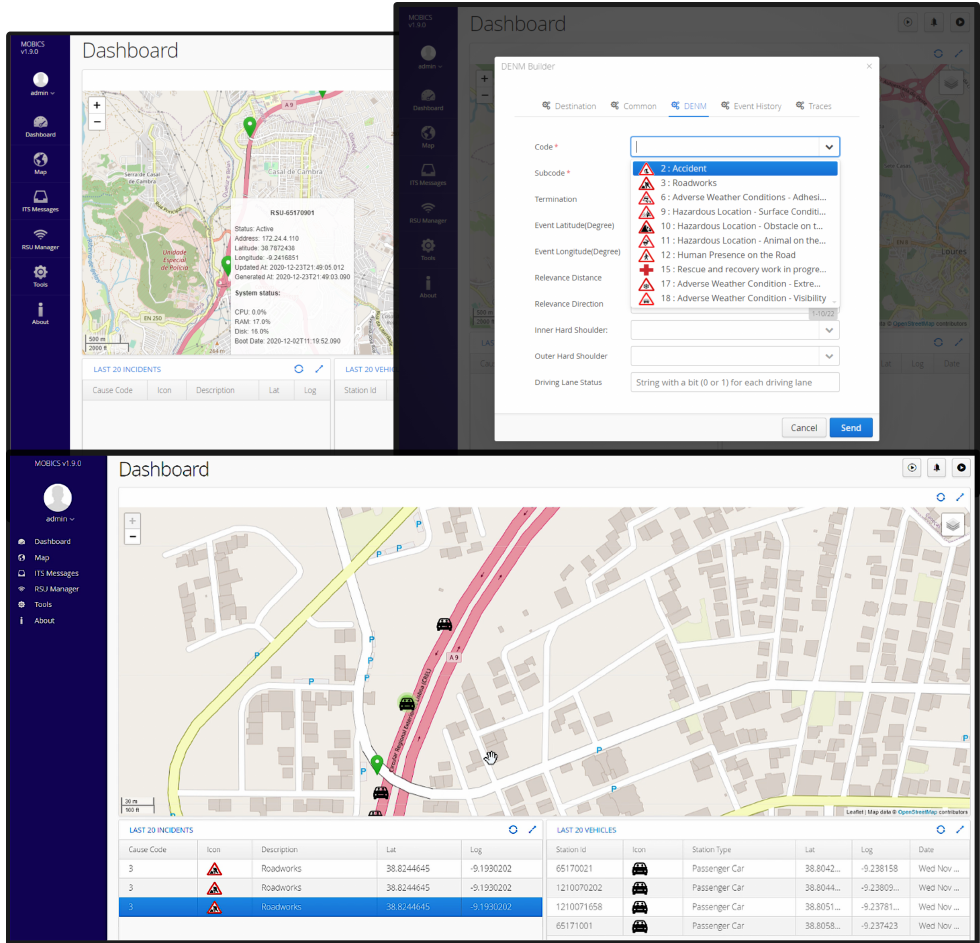
Figure 5. MOBICS dashboard interface, version 1.9.0 (current). Features include, the monitoring of RSUs statuses ( top left ), generation of events ( top right ), and traffic and history overview ( bottom